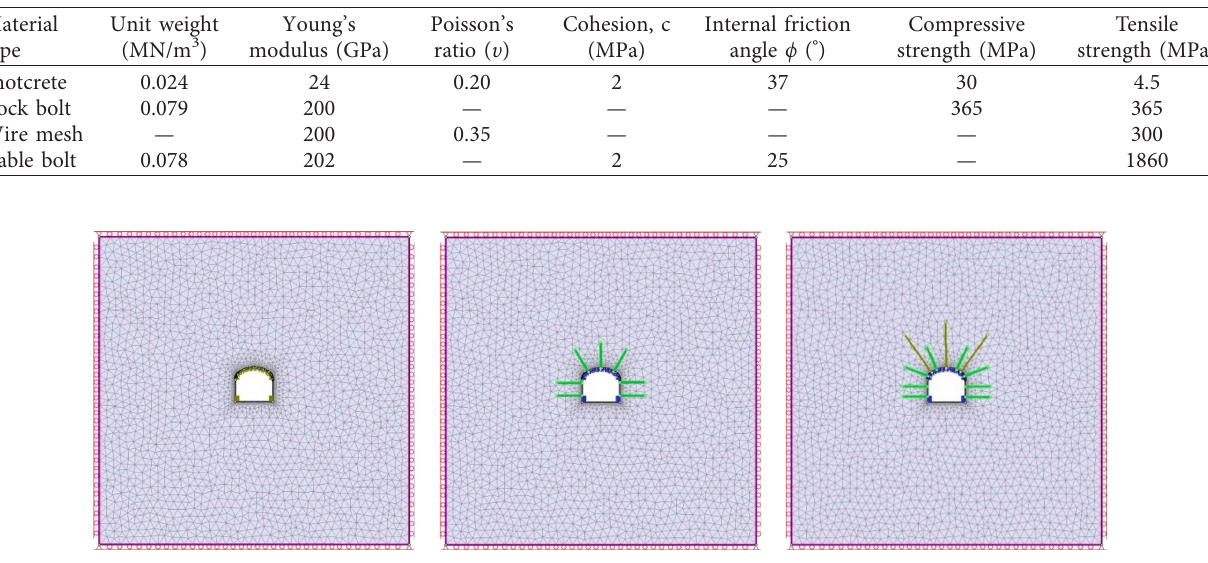
Table 6: The properties of the support elements employed in the analyses.